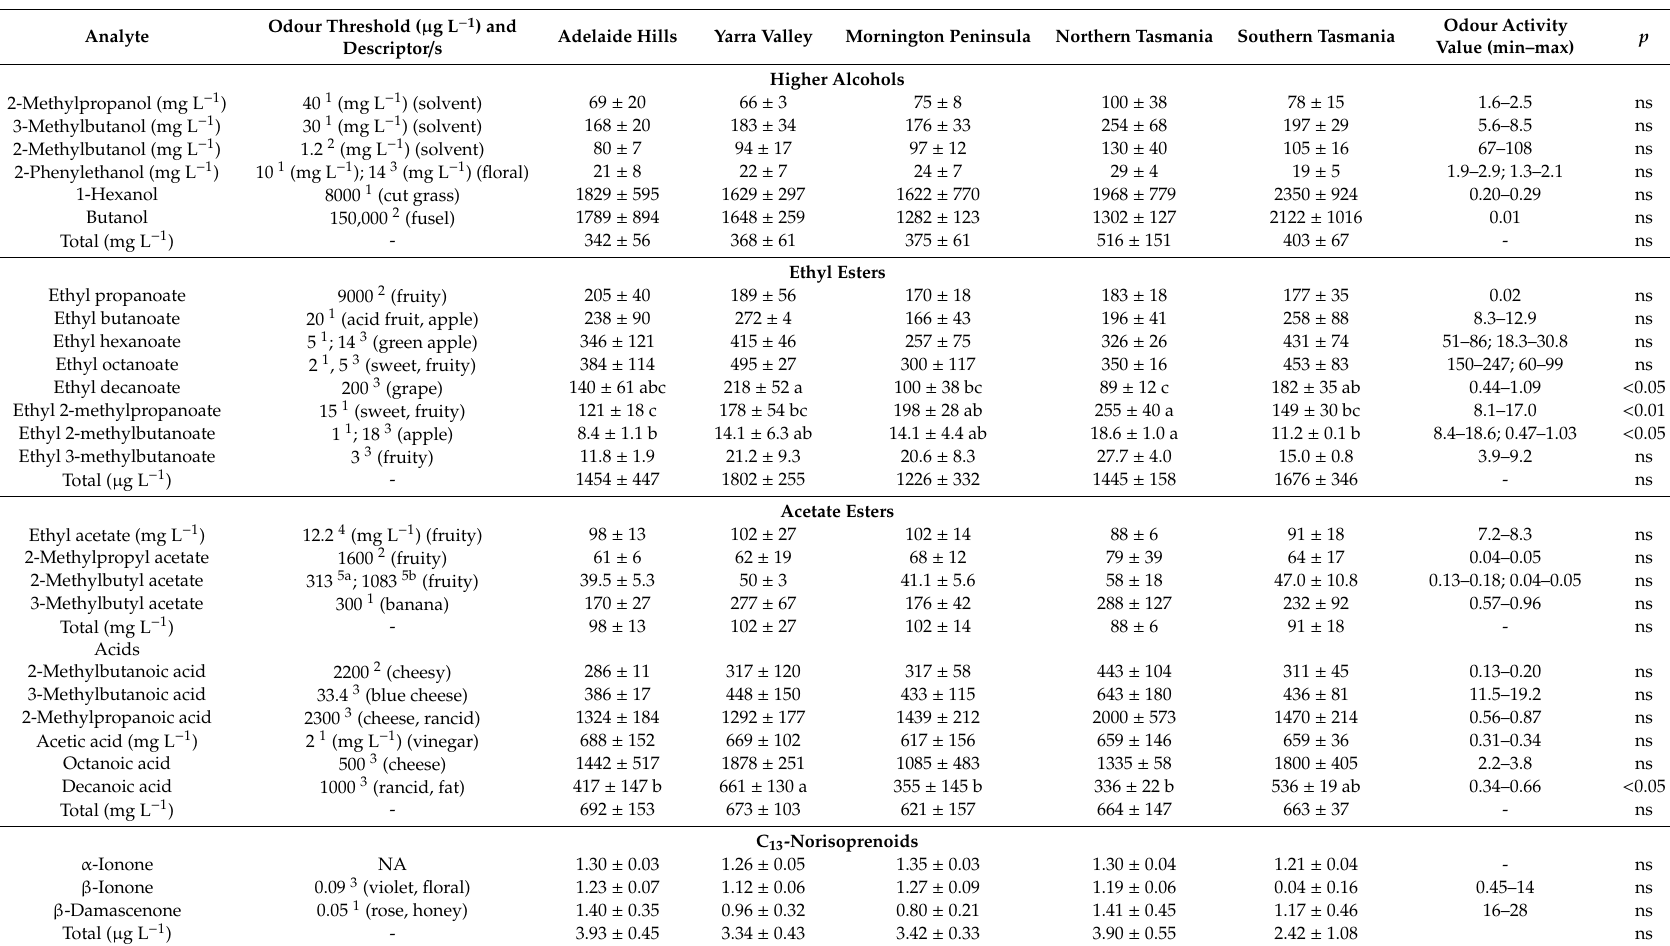
Table 3. Means ( µ g L − 1 ) ( ± SD) of compound concentrations in 2018 Pinot noir wines ( n = 3 per region) with associated odour thresholds and aroma descriptors.